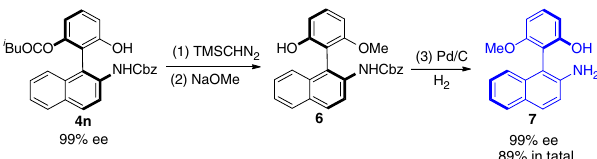
Fig. 5 Synthetic transformations. Reaction conditions: (1) 4n , TMSCHN 2 , CHCl 3 :MeOH/5:1, r.t., 24 h. (2) NaOMe, MeOH, r.t., 1.0 h. (3) Pd/C, H 2 , MeOH, r.t., 3.0